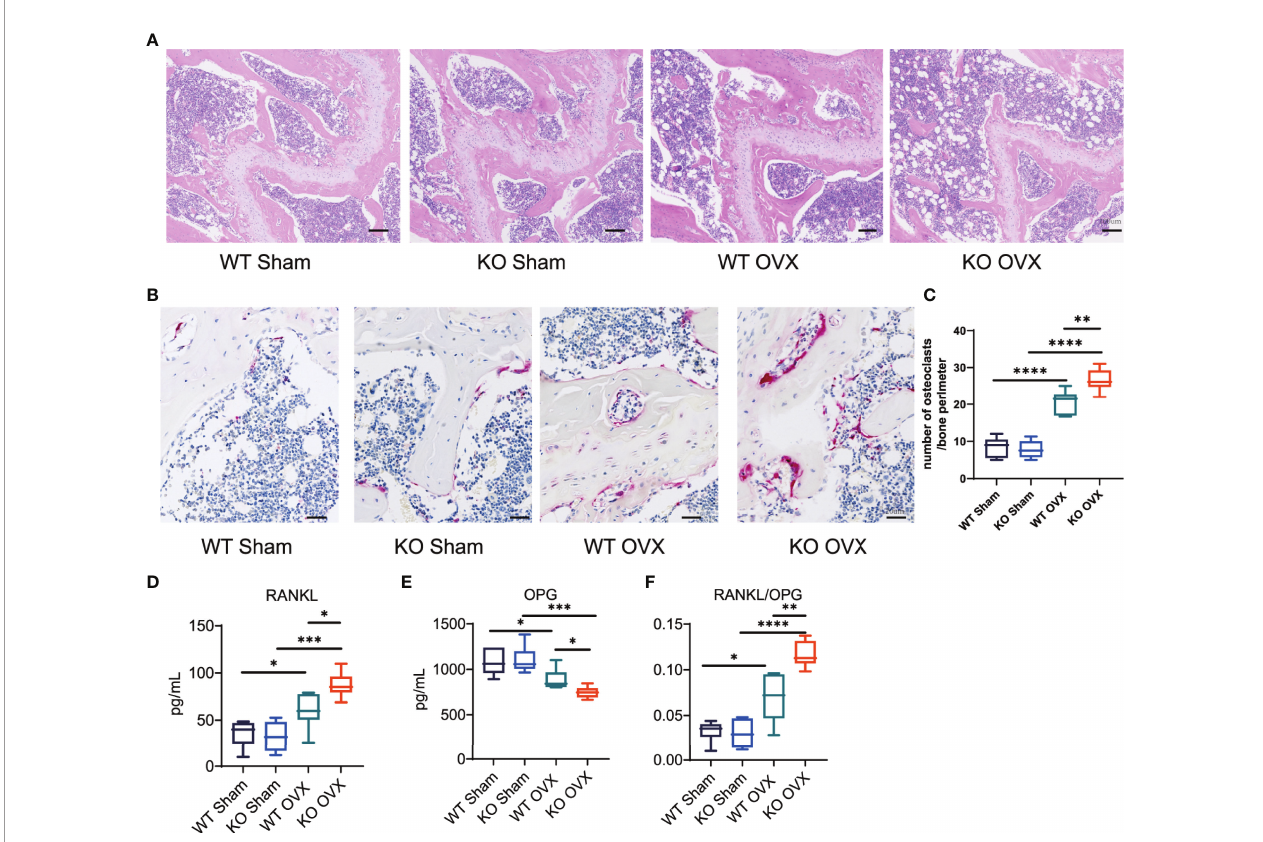
FIGURE 4 | Impacts of NTCP de fi ciency on osteogenesis and osteoclastogenesis in OVX mice. (A – C) Representative H&E-stained (A) and TRAP-stained (B) femur tissue sections from WT SHAM, KO SHAM, WT OVX, and KO OVX mice. The ratio of TRAP-positive cells in the fi eld was counted in each group (C) . (D – F) Levels of RANKL and OPG, and RANKL to OPG ratio of WT SHAM, KO SHAM, WT OVX, and KO OVX mice. n = 6 mice per group. *, p < 0.05; **, p < 0.01; ***, p < 0.001; and ****, p <